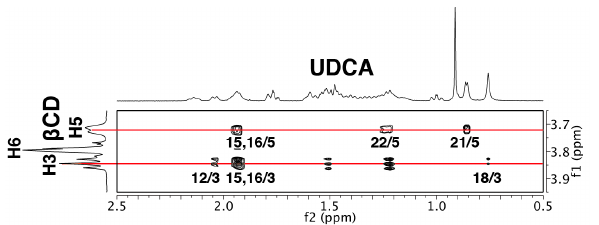
Figure 10. ROESY spectrum of the β -CD / UDCA complex in D 2 O with mixing time of 300 ms.